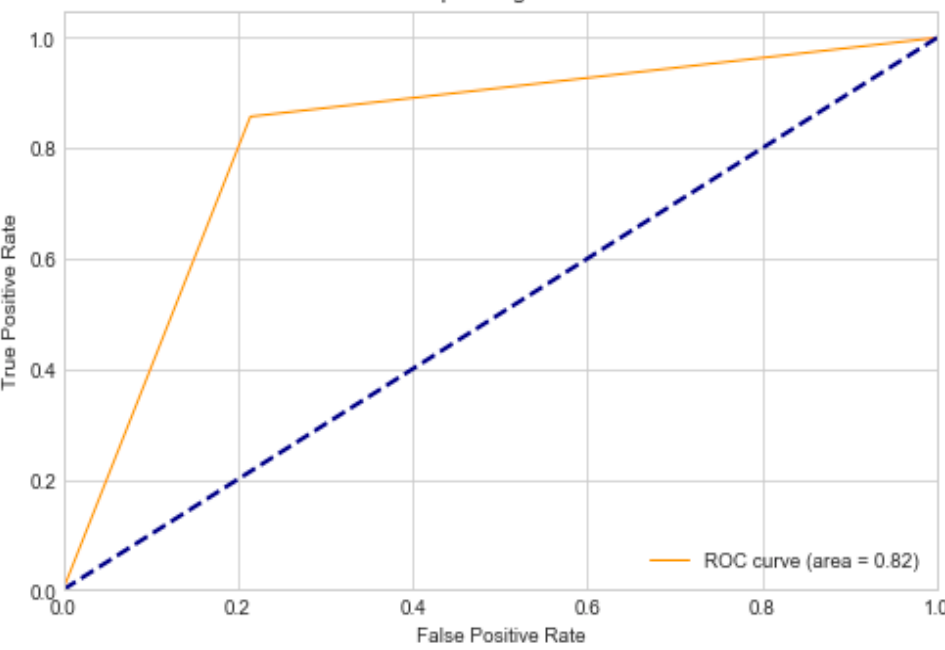
Figure 9. Training and validation loss for the first 20 epochs with a stable difference in training and validation loss showing a good fit curve.